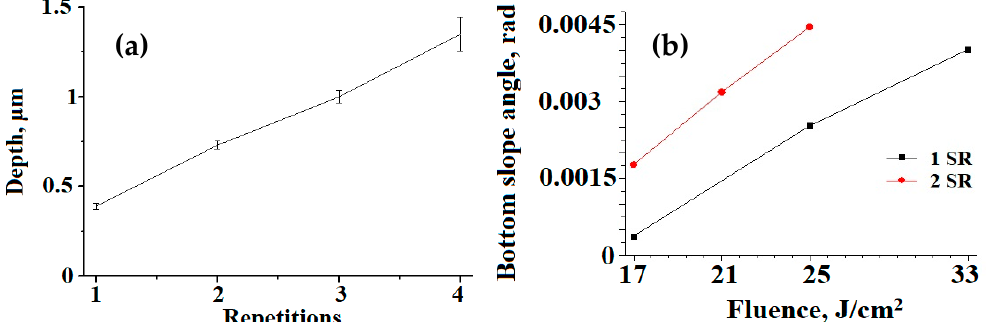
Figure 4. Profile parameters: ( a ) depth of laser-treated areas at 160 µJ; ( b ) average slope angle of treated area bottom.